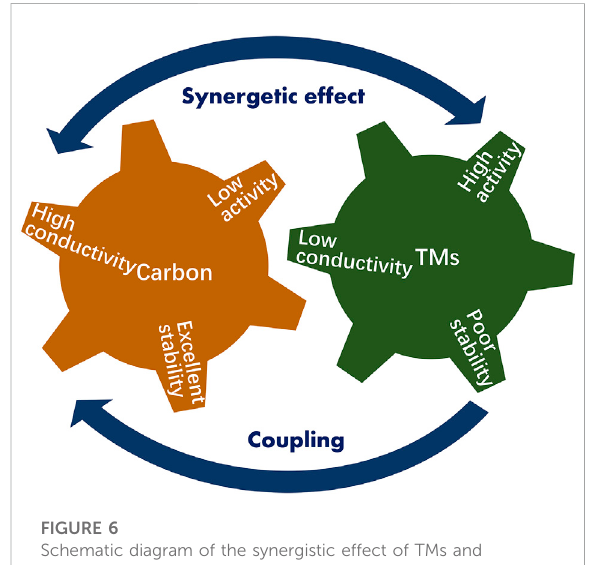
FIGURE 6 Schematic diagram of the synergistic effect of TMs and carbon